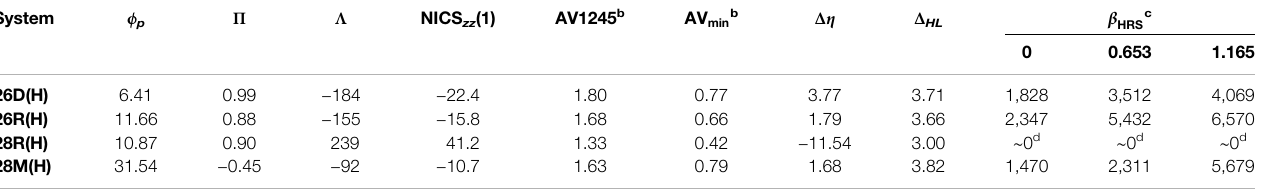
TABLE 1 | Structural parameters, aromaticity descriptors and static and dynamic HRS fi rst hyperpolarizability of the unsubstituted hexaphyrins a . System ϕ